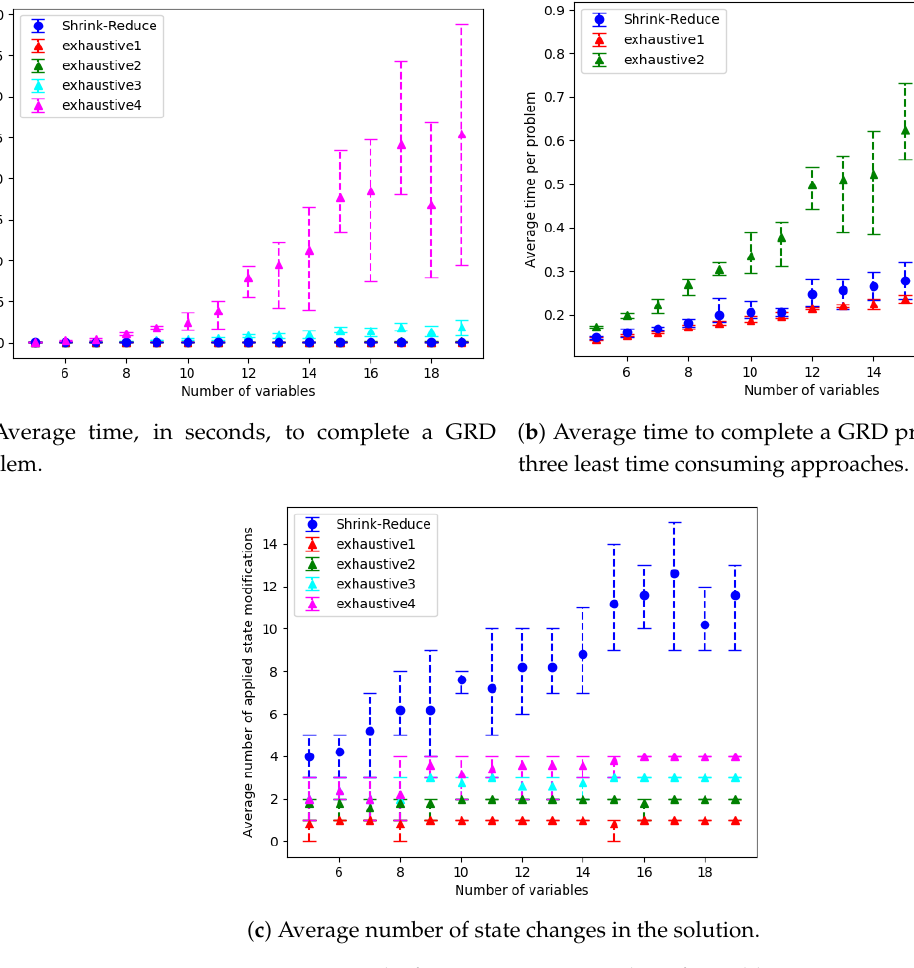
Figure 14. Results for an increasing number of